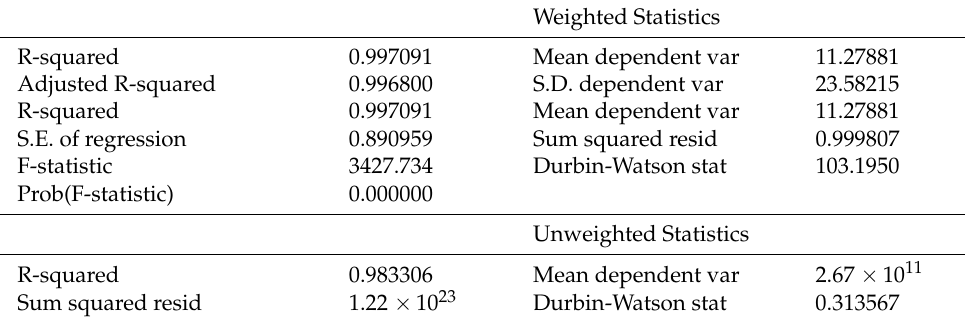
Table 6. Cross-section fixed (dummy variables).